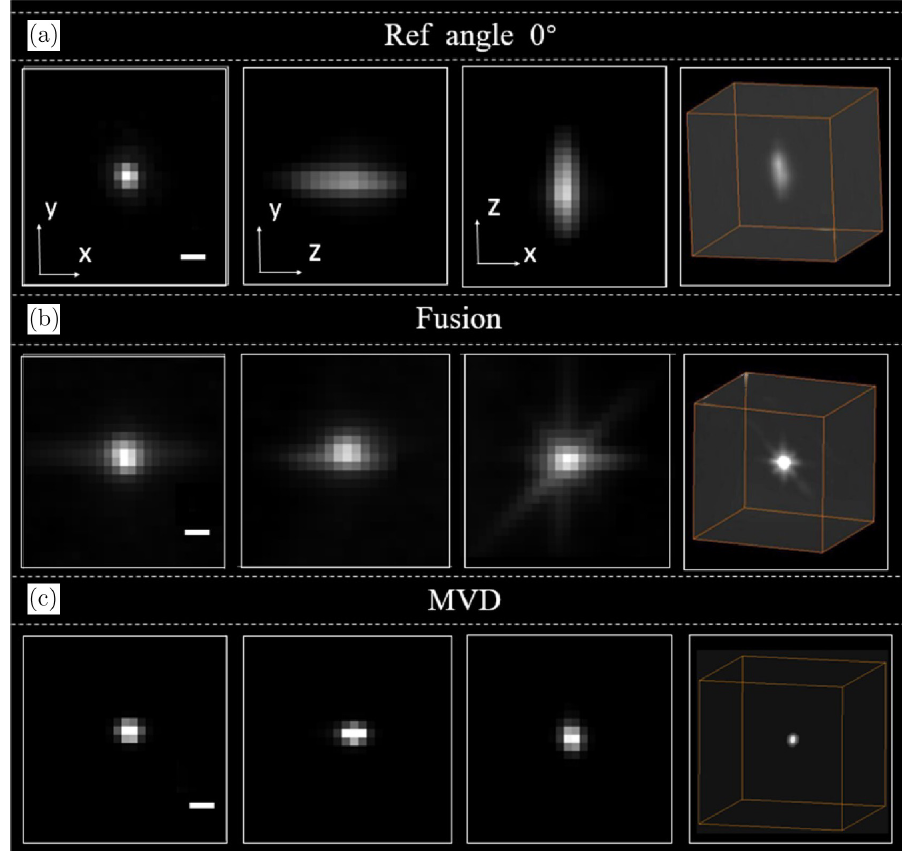
Fig. 2. Characterization using °uorescent bead. (a) – (c) compare the °uorescent beads ( (cid:1) 1 (cid:1) m) resolved by single-view LSFM (angle 0 (cid:3) ). 8-view fusion and 8-view Bayesian deconvolution, respectively. The x – y , y – z , x – z planes and 3D rendering of the bead are shown from the left to the right. Scale bar is 5 (cid:1)